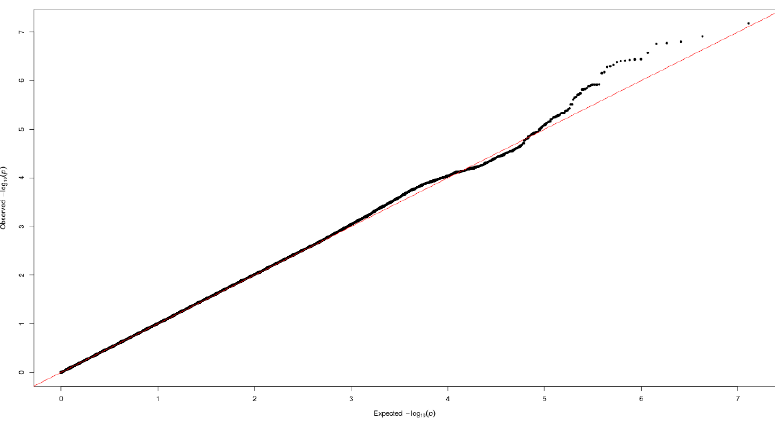
Figure 3. Quantile-quantile (Q-Q) plot of the GWAS on coffee consumption.